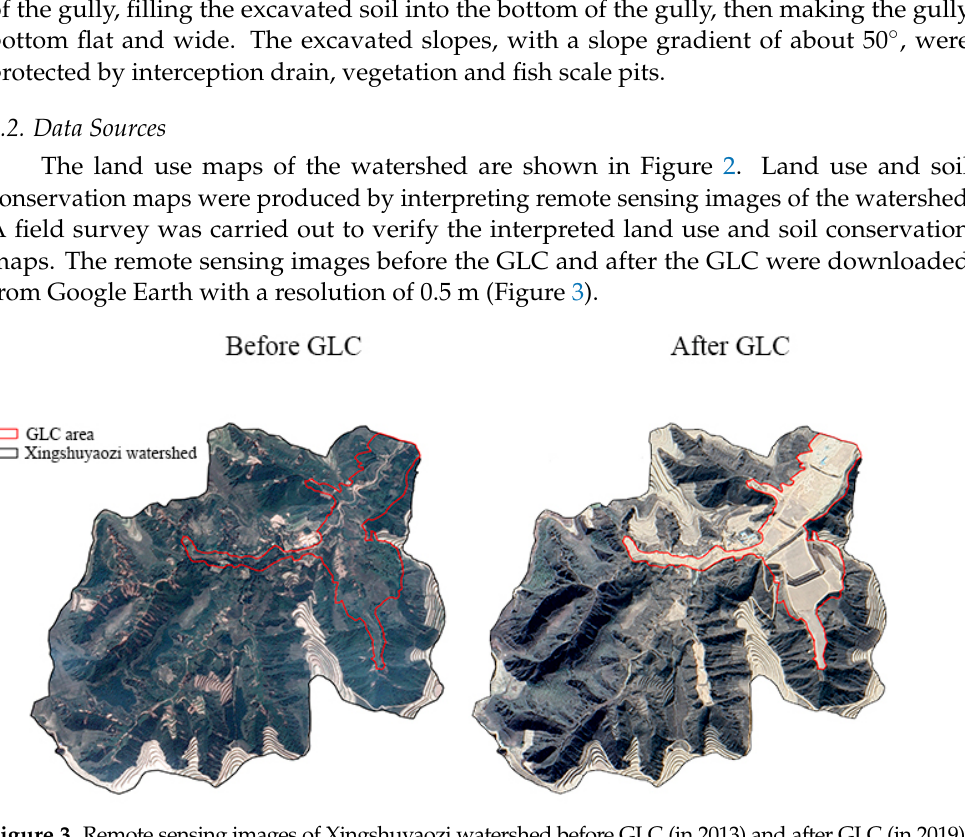
Figure 3. Remote sensing images of Xingshuyaozi watershed before GLC (in 2013) and after GLC (in